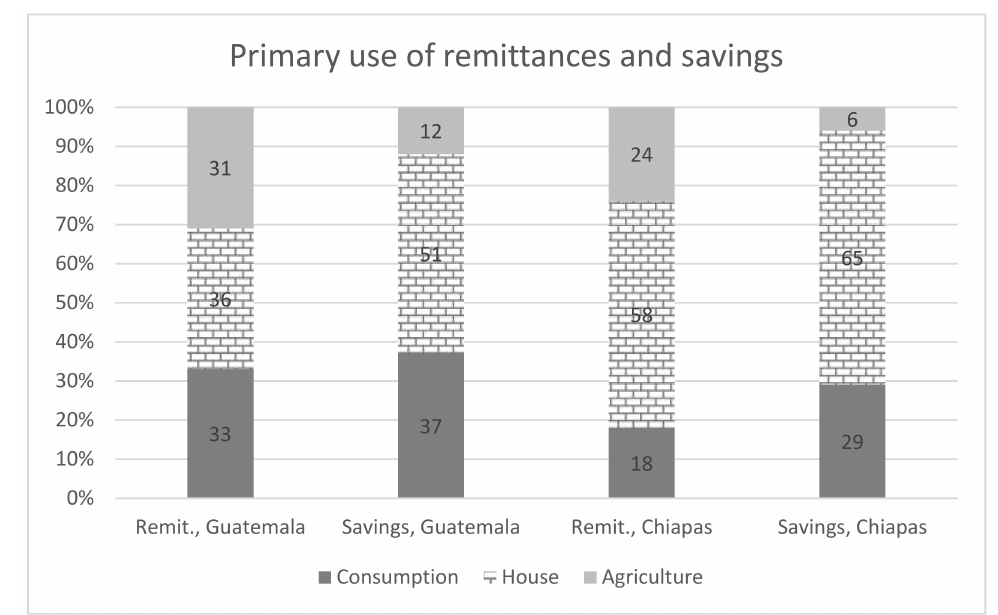
Figure 7. Primary use of remittances and savings by